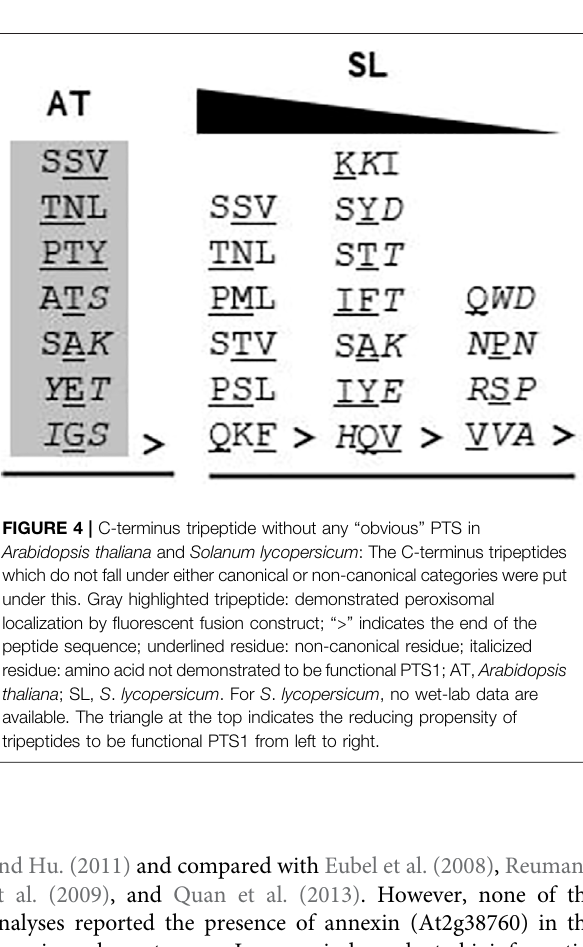
Frontiers in Cell and Developmental Biology |